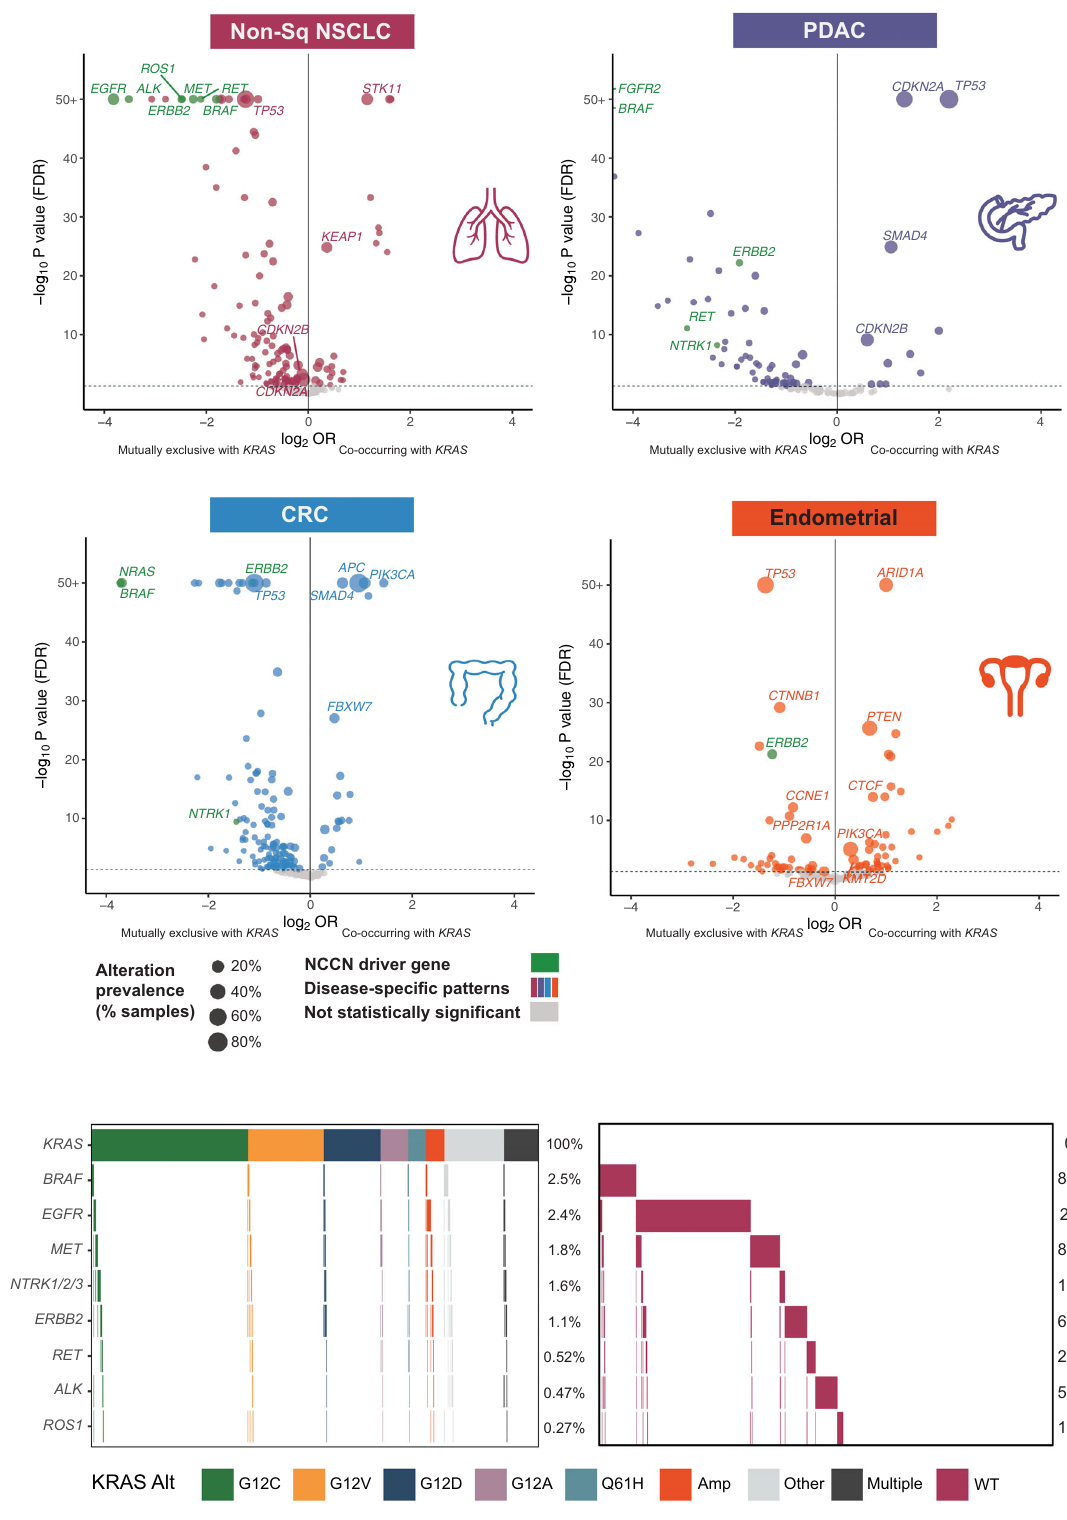
signi fi cant. KRAS / NRAS / BRAF V600E negative ( RAS / RAF negative) patients had more favorable OS than the KRAS G12C subgroup (24 vs. 19 mos, HR 0.74, 95% CI 0.59 – 0.93, p = 0.009), which was consistent in a multivariable model (Fig.